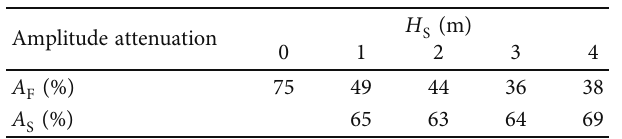
Table 4: Amplitude attenuation values (1 ~ 5 working